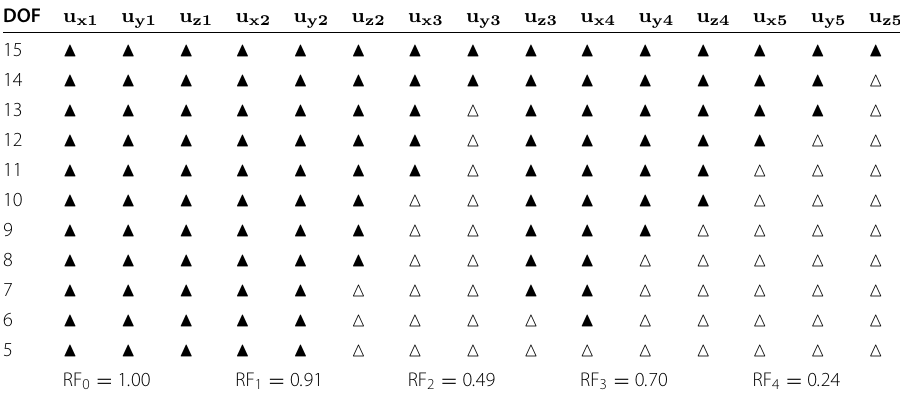
Table 17 BTD models, 0/90/0, a/h =